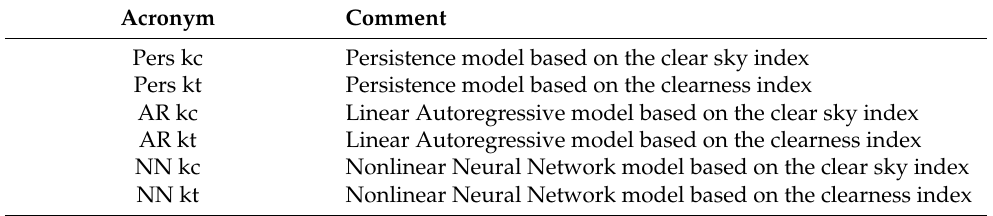
Table 2. List of models used in this